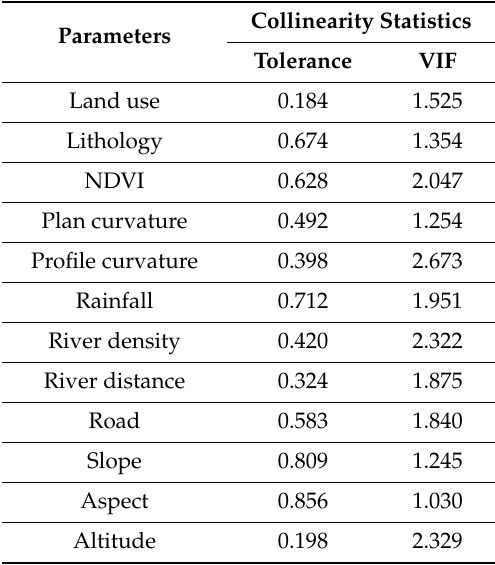
Table 2. Multi-collinearity statistics for the gully erosion a ff ecting